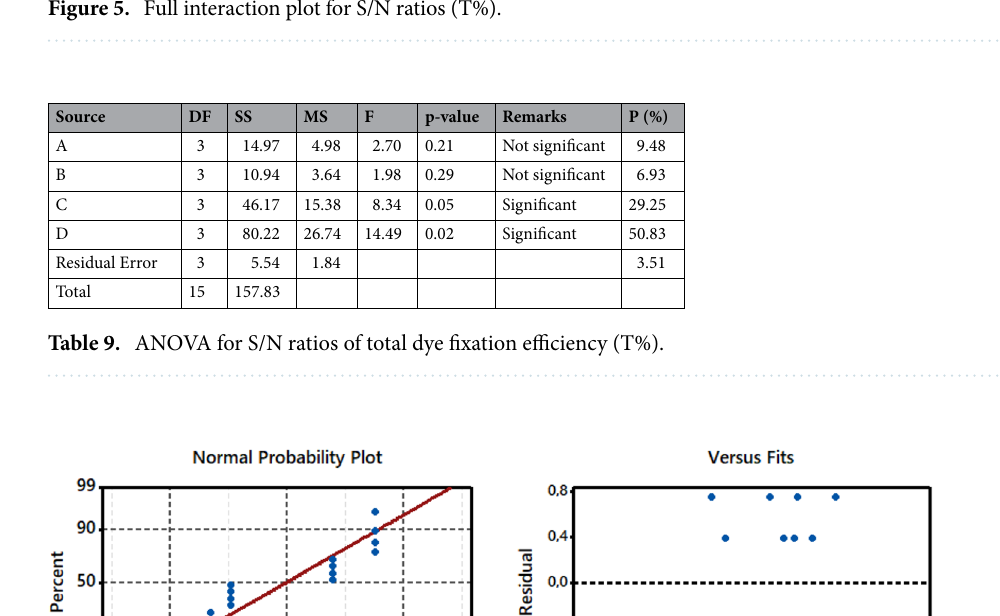
Figure 5. Full interaction plot for S/N ratios (T%).